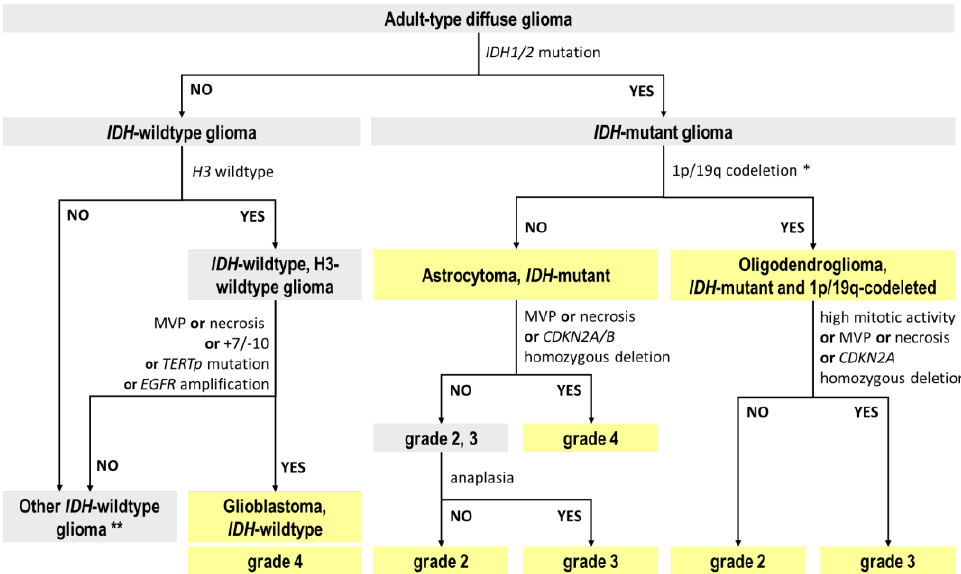
Figure 1. Algorithm of the classification of diffuse gliomas according to the 5th edition of the WHO Classification of tumors of the CNS (WHO CNS5). MVP — microvascular proliferation. * ATRX mutation in an IDH -mutant diffuse glioma is sufficient for the diagnosis of IDH -mutant astrocytoma, obviating the need for 1p/19q testing in order to exclude oligodendroglioma. ** For IDH -wildtype gliomas without molecular features of a glioblastoma or when they are unknown it is worth performing a differential diagnosis from pediatric-type diffuse gliomas, especially in the case of young adults.